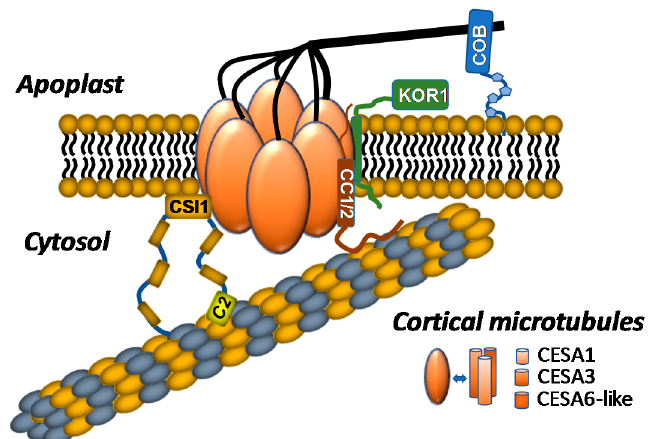
Figure 1. The current model of the plant cellulose synthase complex (CSC) and CSC-associated proteins in vivo is shown. CSC forms hexagonal rosettes with 3 subunits of cellulose synthase A (CESA) comprising 1 rosette lobe, resulting in 18 CESAs within each CSC. CSC-associated proteins include cellulose synthase interactive protein 1 (CSI1), companion of cellulose synthase 1/2 (CC1/2), KORRIGAN1 (KOR1), and COBRA. CSI1 bridges CSCs to the cortical microtubules (MTs) through binding of its C2 domain and facilitates bidirectional movement of CSCs through the plasma membrane. CC1 and CC2 bind to MTs via the CC1/2 N-terminal domain, which is needed for maintaining CSC activity and MT dynamics under salt stress. KOR1 is an integral component of the CSC and possibly regulates cellulose biosynthesis through its endo-1,4-ß- D -glucanase activity. COBRA, a glycosylphosphatidylinositol (GPI)-anchored protein, is located in the extracellular matrix and regulates CSC activity, cellulose organization, and interaction with other cell-wall components.